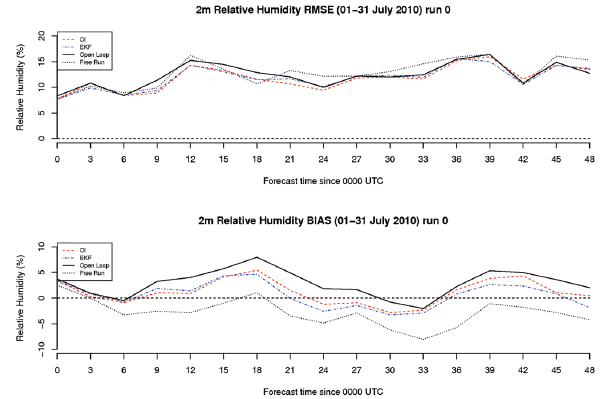
Fig. 15. Root-mean-square error and BIAS for relative humidity at Uccle averaged over the month July 2010 for optimum interpolation (OI), extended Kalman filter (EKF), open loop and free